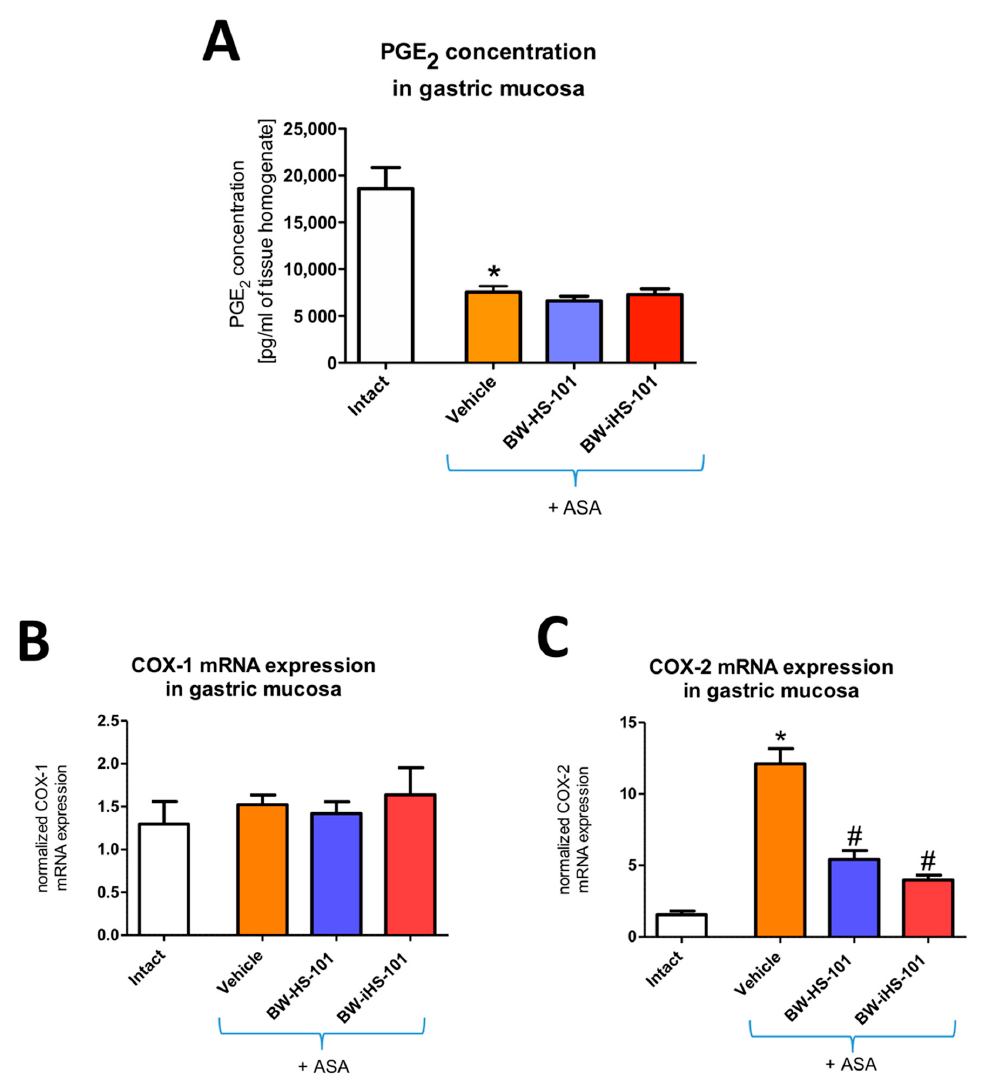
Figure 6. Gastric mucosal concentration of prostaglandin E 2 ( A ) and mRNA expression of cyclooxygenase (COX)-1 ( B ) and COX-2 ( C ) in rats administered i.g. with acetylsalicylic acid (ASA, 125 mg/kg) and pretreated 30 min earlier with vehicle, BW-HS-101 (50 µ mol/kg) or BW-iHS-101 (50 µ mol/kg). Results are mean ± SEM of five rats per each experimental group. Significant changes as compared with the respective values in intact rats are indicated by asterisk (*) ( p < 0.05). Hash (#) indicates significant changes as compared with vehicle ( p <